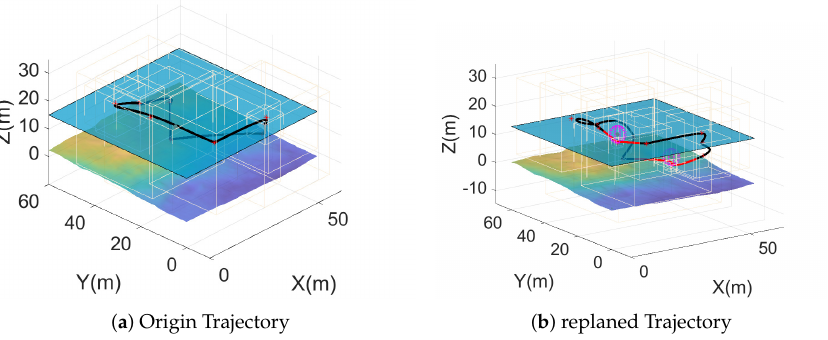
Figure 19. A comparison of a whole original path and a replanned path. Two obstacles appeared within the duration. The weighted length of the trajectory was 863.7285. The partly replanned path is marked in red. Collision-free spots on the free sphere around obstacles are illustrated as free obsets. The number of spots in the obstacle set was 49. Each iteration of R 100 spots on the collision-free sphere was traversed.